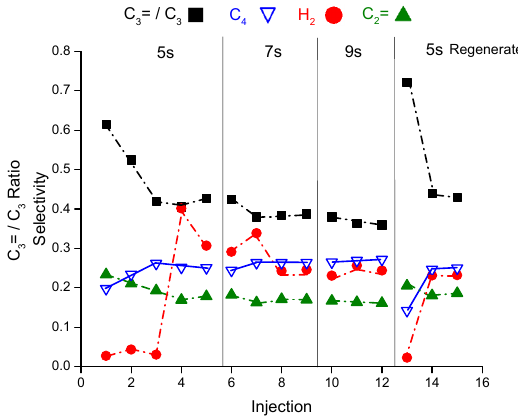
Figure 4. C 3 = / C 3 ratio ( ⬛ ), H2 ( ⚫ ), C 2 = ( ⯅ ), and C 4 ( ) selectivity as function of reaction time at 460 °C measured for the riser simulator reactor. Results after regeneration at 5 s are also shown. Injection #1 done on the fresh sample. Please note the injection number after regeneration should start from number 14 to 16 but we reassigned them to 13–15 for simplicity.